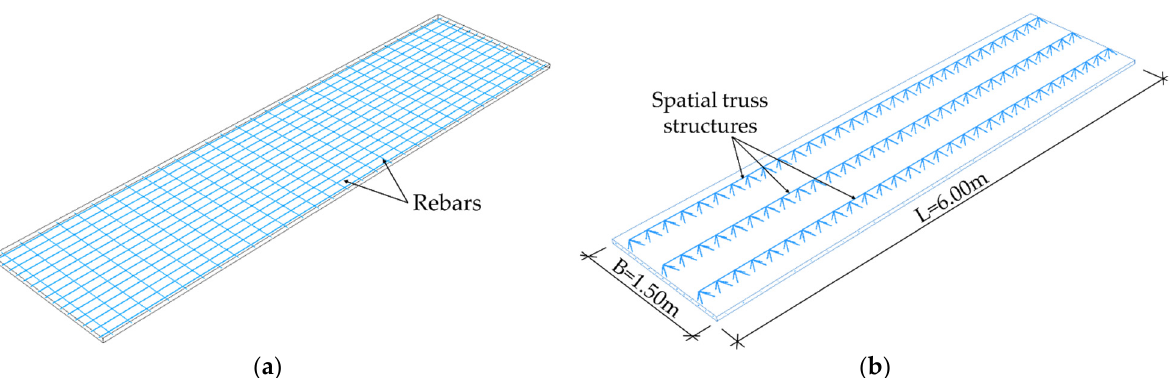
Figure 5. Filigree ceiling slab with D-type trusses ( a ) rebars; ( b ) concrete slab. In the numerical model 2, a Filigree ceiling slab with EQ-type trusses was modelled. The dimension of EQ-type trusses is shown in Figure 2. The trusses and reinforcement were modelled as steel wire structures, whereas the slab was made of concrete and mod-